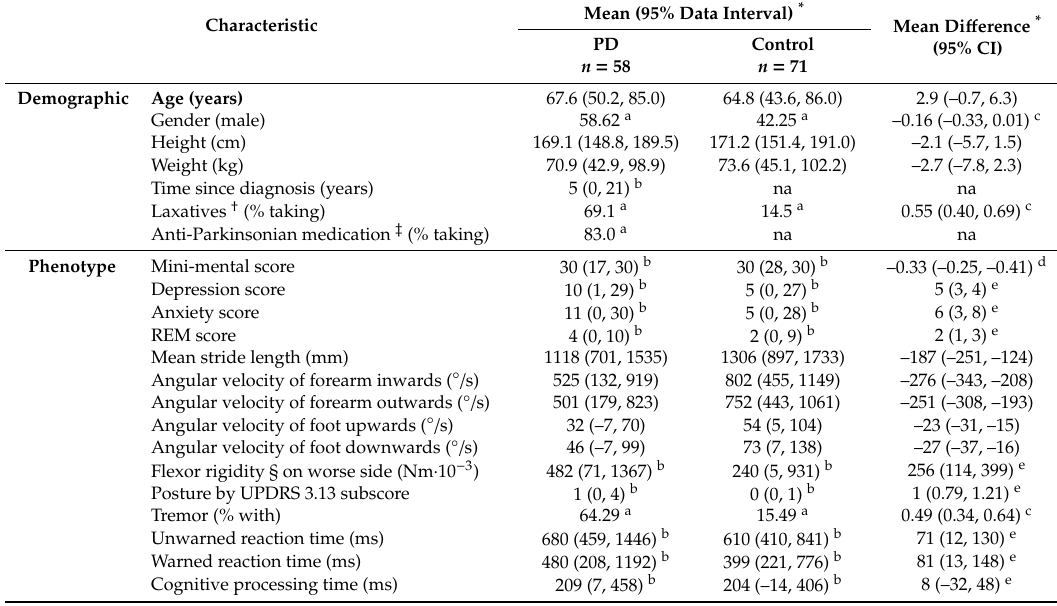
Table 1. Participant characteristics at time of colonic transit time test